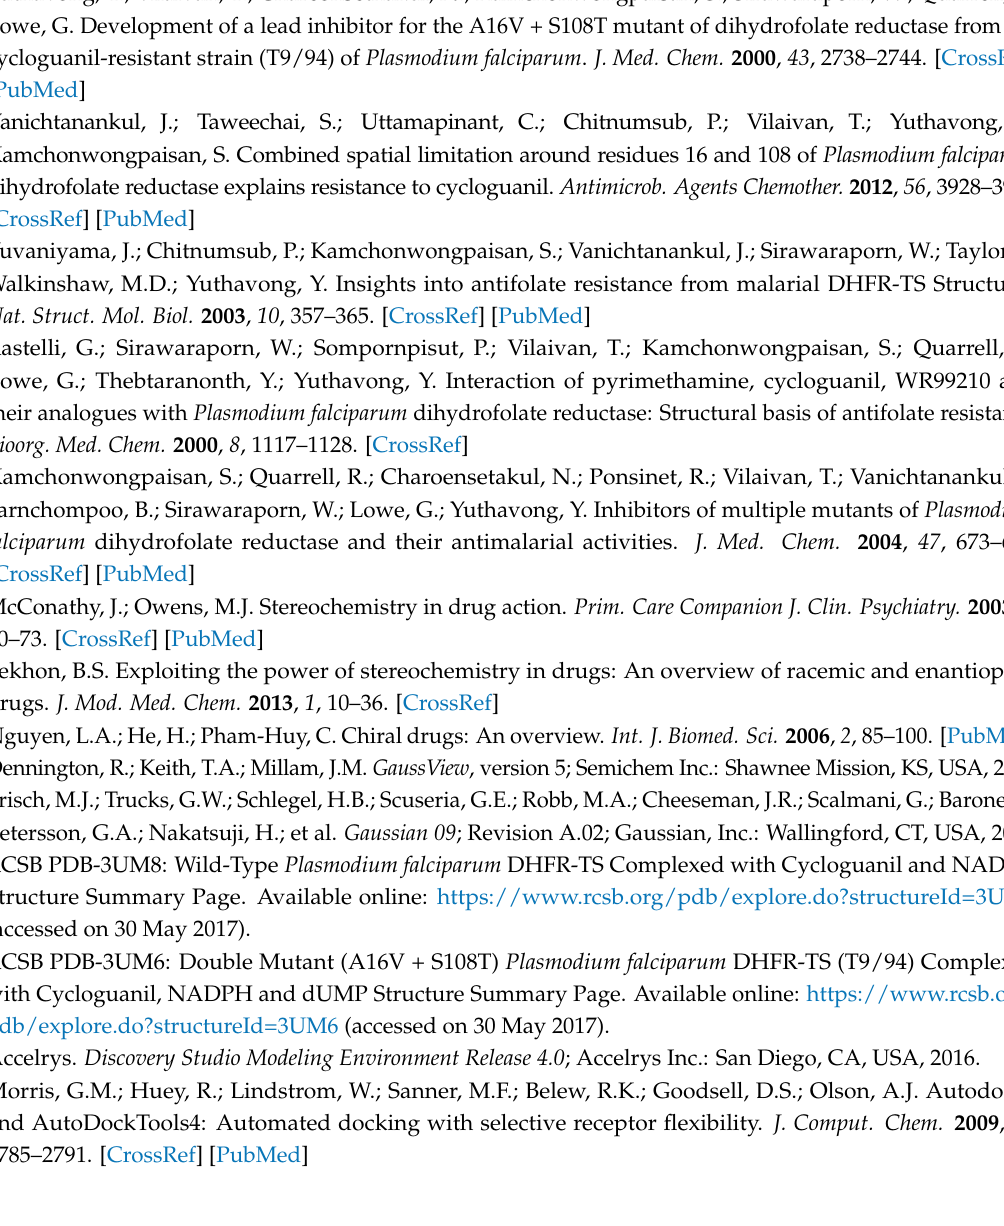
Table S1: Binding energy (BE) of Cyc derivatives (kcal mol − 1 ) for binding with the wild-type pf DHFR